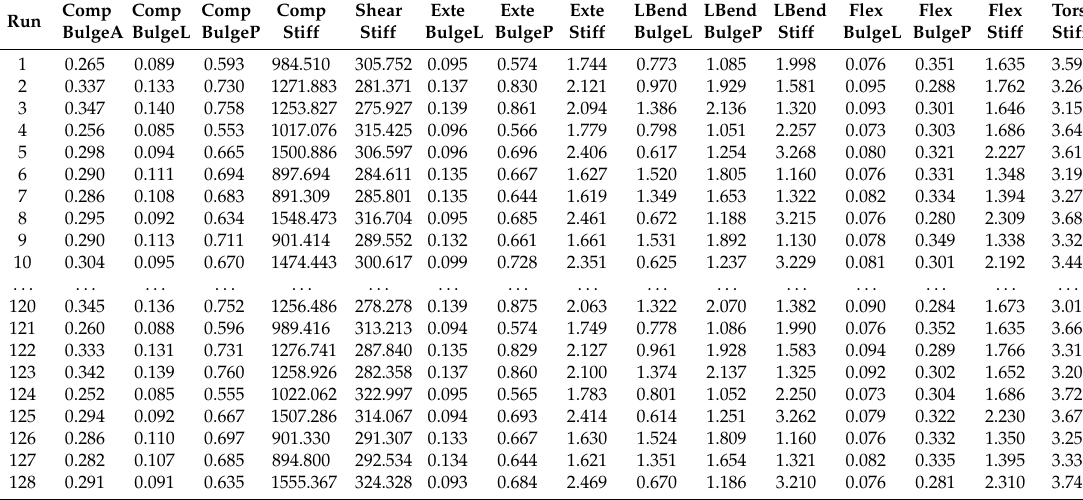
Table 10. Results of the simulation of FE models when a combination of 128 material parameters are considered in Table